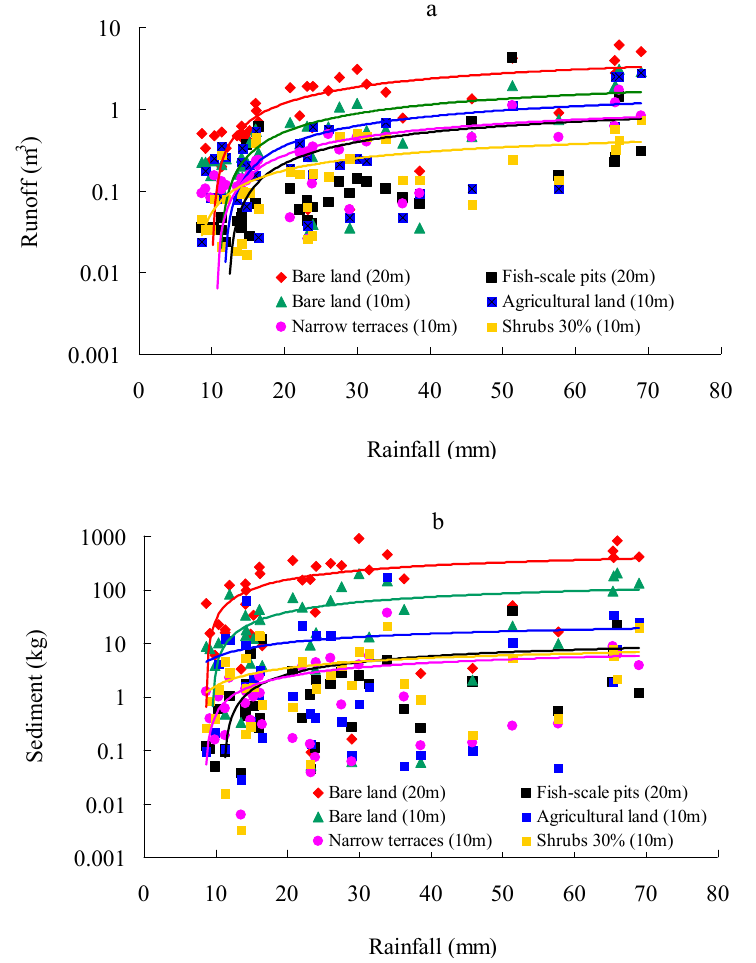
Figure 3. Relationship between runoff, sediment and rainfall under different soil and water conservation practices; ( a ) relationship between runoff and rainfall; ( b ) relationship between sediment and rainfall.